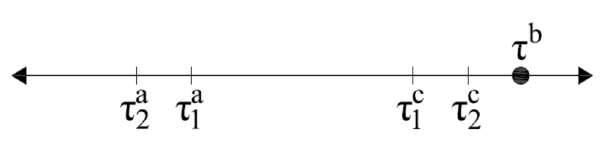
Figure 4. Example shear-stress limits on a one-dimensional plot. Table 5. Summary of active crack criteria.